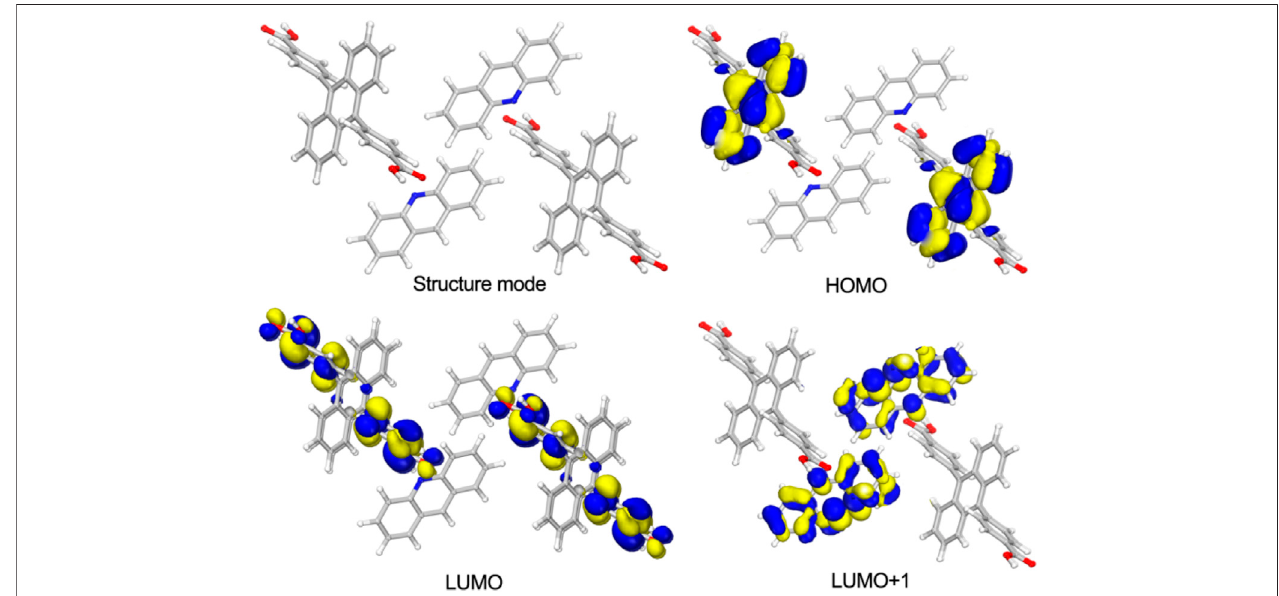
FIGURE 4 | The structure mode and selected molecular orbitals of [(DCPA) (AD) 2 ].